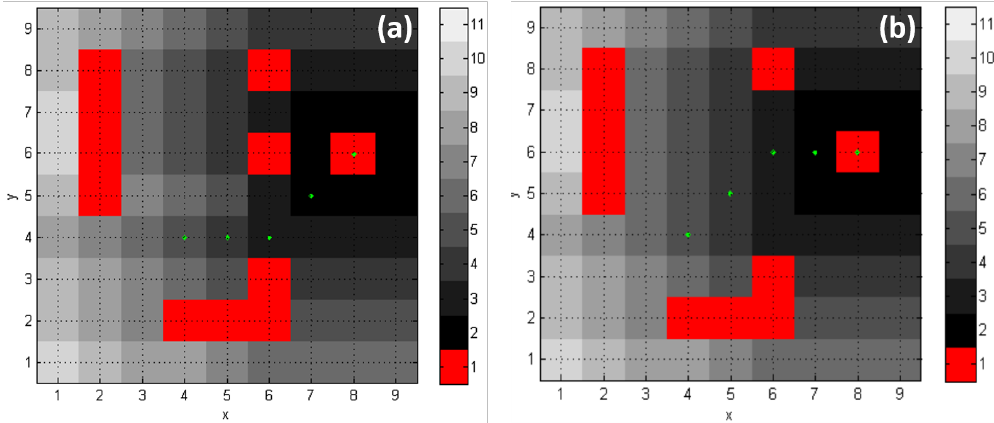
Figure 17. Re-planned trajectory route compared to the original one. ( a ) The re-planned robot trajectory after an obstacle was detected at g ( 6,6 ) ; ( b ) The original robot trajectory